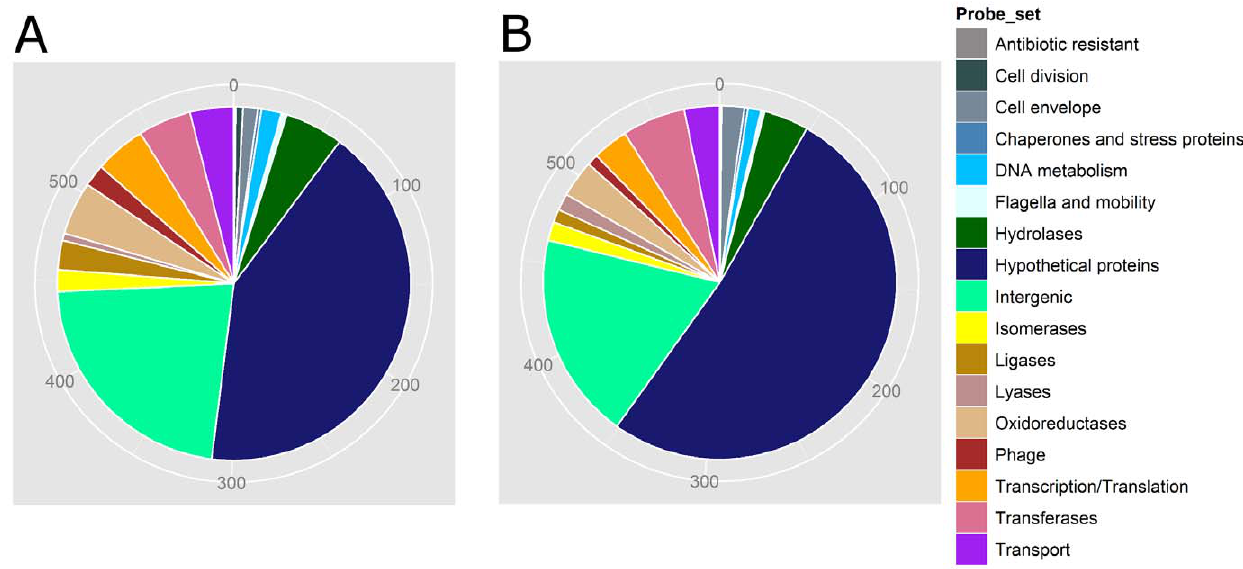
Figure 5. Diagrammatic representation of the distribution of unique probe-sets of the serotype 1/2a 2011 cantaloupe outbreak strains from different PFGE pattern combination groups based on their functions. A) Probe sets uniquely present in the strains from the PFGE pattern combination I and absent in both PFGE pattern combination III and IV. B) Probe sets uniquely present in the strains from the PFGE pattern combination III and IV and absent in the PFGE pattern combination I. The numbers of probe-sets were indicated in the periphery of the pie- chart.